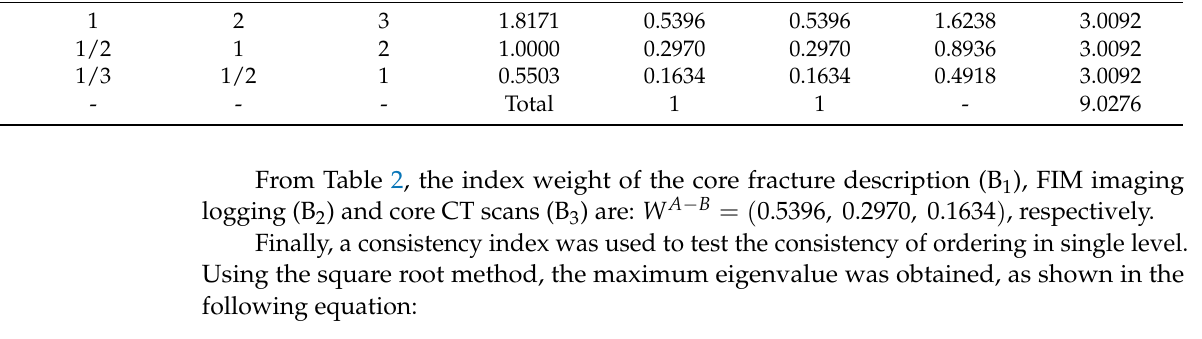
Table 2. A-B index weight using the square root method.